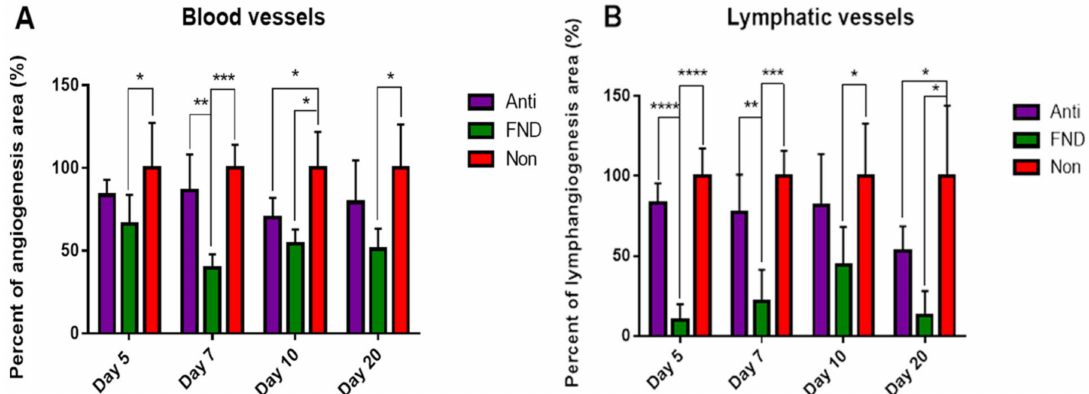
Figure 7. Effect of fine needle diathermy (FND) on regression of blood vessels ( A ) and lymphatic vessels ( B ) at four time points after treatment (after 14 days of corneal suture placement to induce inflammatory corneal neovascularization). Compared to the non-treated group (NON: red column), the FND treated group (green column) resulted in significant regression of both blood and lymphatic vessels at all four time points ( p < 0.05; Anti: anti-inflammatory treatment only, purple column). The most obvious effect of FND is observable at day 7 with the reduction of hemangiogenesis by 60% ( p < 0.0001) and lymphangiogenesis by approximately 80% ( p < 0.0001) as compared to the NON group. (* p < 0.05; ** p < 0.01; *** p < 0.001; **** p < 0.0001). From Le et al. 2018